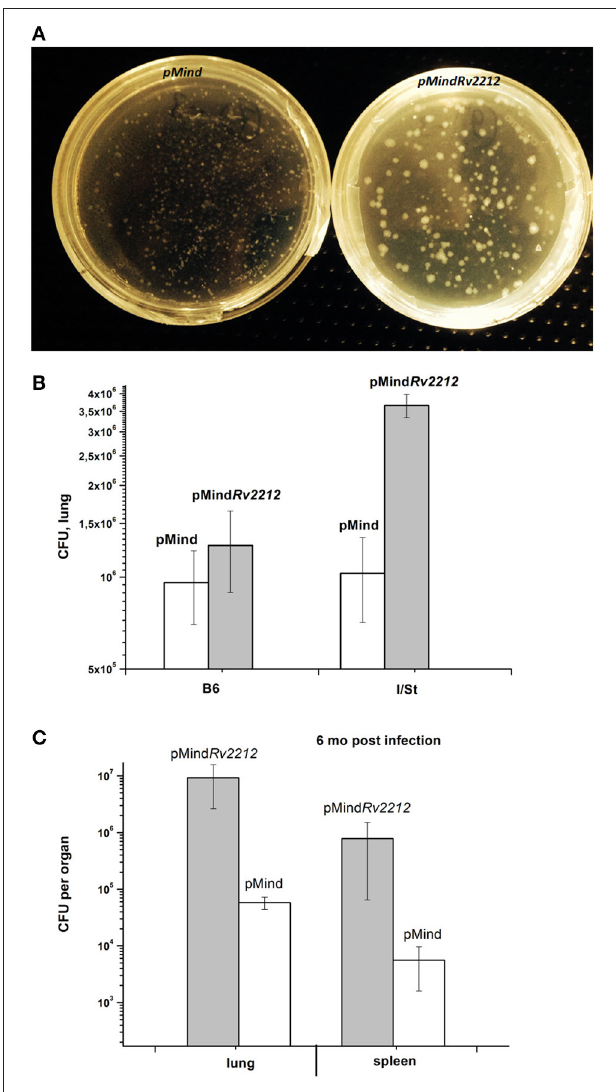
FIGURE 5 | M. tuberculosis pMind Rv2212 and pMind phenotypes expressed in vivo . (A) pMind Rv2212 strain (left) isolated from lungs provided larger colonies compared to the control strain (right). Lungs of infected B6 mice were homogenized, plated on Dubos agar, kept at 37 ◦ C for 3 weeks and photographed. (B) Mice of I/St and B6 inbred strains were infected with 5 × 10 6 CFUs of M. tuberculosis pMind Rv2212 or pMind. At week three post-infection, lungs were homogenized and serial dilutions were plated on Dubo medium. The results of two experiments including 4 mice each (total N = 8) are expressed as mean ± SEM. Significant difference ( P < 0.01, ANOVA) was observed between pMind Rv2212 -infected B6 and I/St mice. (C) At 6 months post-challenge, ∼ 2 log differences ( P < 0.001, ANOVA) were observed between multiplication of pMind Rv2212 and pMind mycobacteria in lungs and spleens of B6 mice. The results are expressed as mean ± SEM ( N = 6).